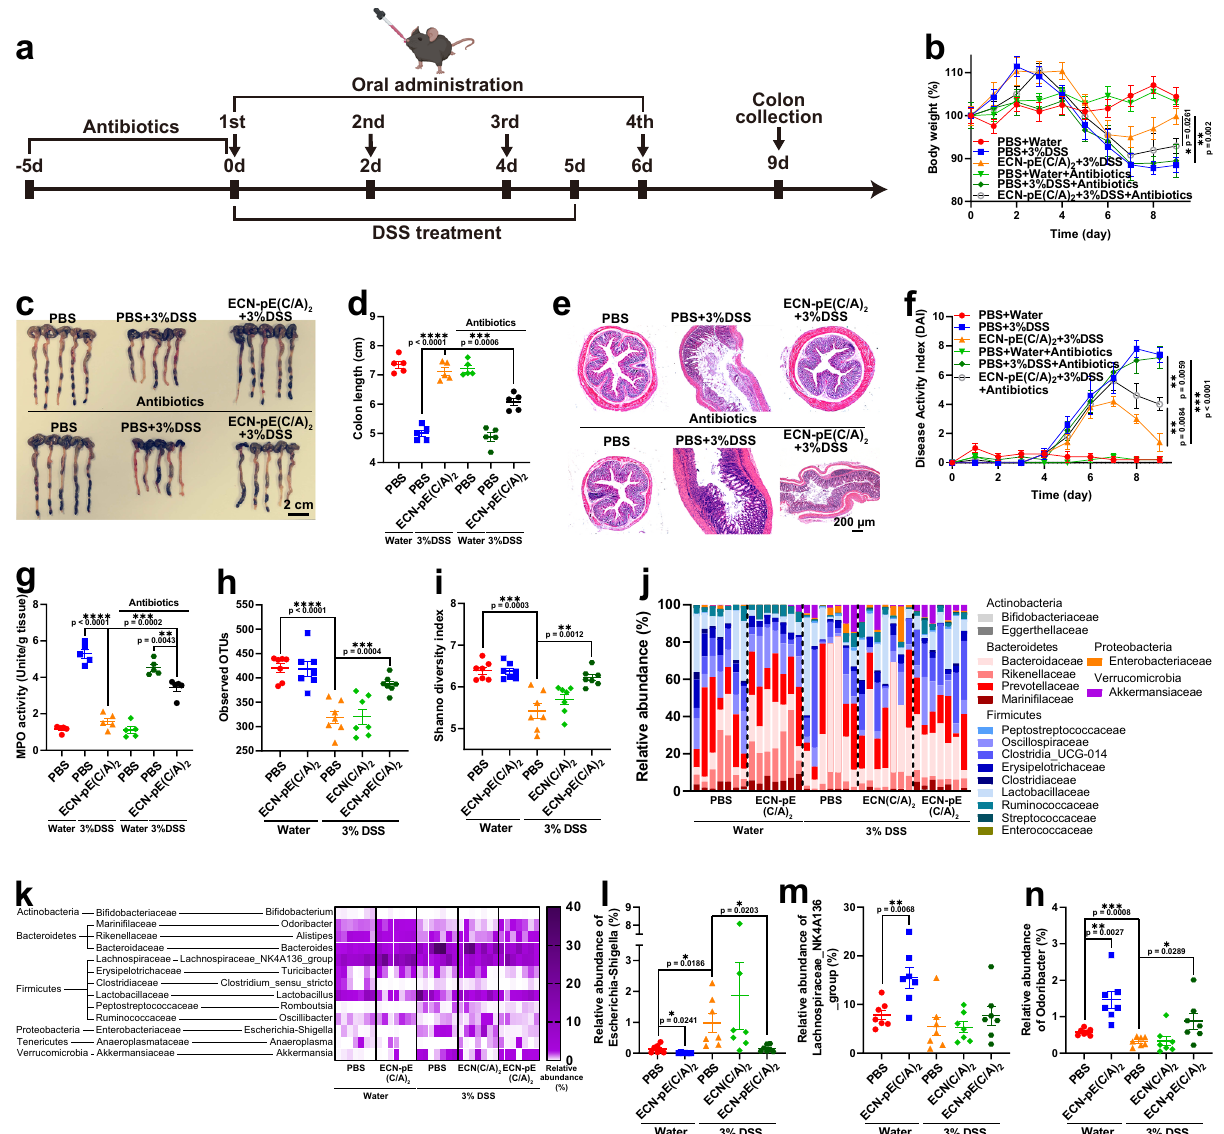
Fig. 5 ECN-pE(C/A)2 modulates intestinal fl ora during IBD treatment. a C57BL/6 mice were fed water containing several antibiotics (metronidazole, neomycin, vancomycin, and ampicillin) for 5 days and then switched to drinking water containing 3% DSS for 6 days. Then, the mice were treated with PBS, ECN(C/A) 2, ECN-pE(C/A) 2 or ECN-pE (1 × 10 8 CFU) on days 0, 2, 4, and 6. b The body weight of mice during the treatment. c Photographs and ( d ) corresponding quanti fi ed lengths of colons harvested from mice 9 days after different treatments. Scale bar: 2 cm. e Representative H&E staining images of colon tissues harvested on day 9 after different treatments from fi ve biologically independent animals in each group. Scale bar: 200 μ m. f The DAI of mice during the treatment. g The MPO activity of colons after treatment. h Observed OTUs and ( i ) Shannon index of gut microbiota in mice after different treatments. OTUs operational taxonomic units. j Relative abundance of gut microbes at the phylum and family levels in mice. k Heatmap illustration of gut microbial distribution at the genus level. Relative abundance of Escherichia – Shigella ( l ), Lachnospiraceae _NK4A136 ( m ), and Odoribacter ( n ) collected from k. Data are presented as mean values ± SEM ( n = 5 biologically independent samples for ( b , d , f , and g ), n = 7 biologically independent samples for ( h – n )). Statistical analysis was evaluated with two-tailed Student ’ s t tests (* P < 0.05, ** P < 0.01, *** P < 0.001, and **** P < 0.0001). DSS dextran sodium sulfate. Source data are provided as a Source Data fi